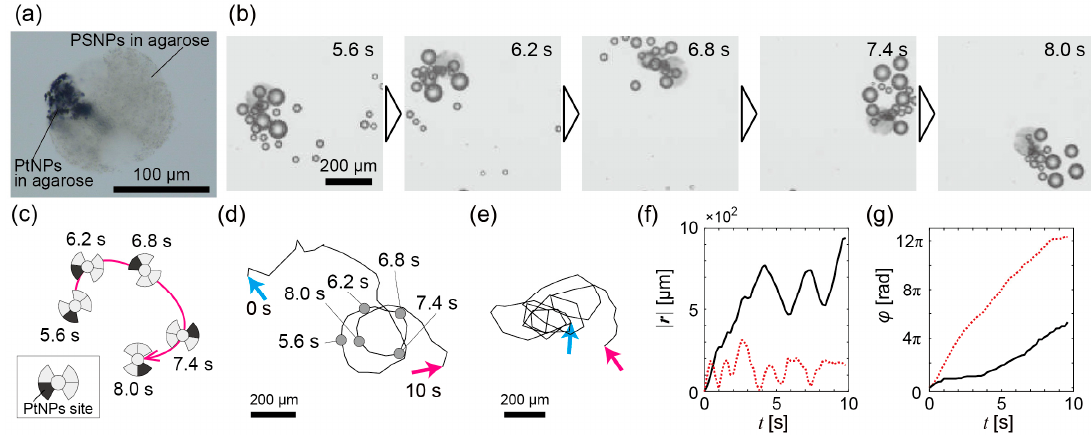
Figure 3. Experimental results of bubble propulsion of the propeller-shaped micromotors with double catalytic sites in the H 2 O 2 solution. ( a ) A microscope image of a propeller-shaped micromotor with double catalytic sites; ( b ) Time series from t = 7.8 s to t = 9.4 s of a propeller-shaped micromotor with double catalytic sites propelled by bubbles; ( c ) Schematic illustration of the trajectory of ( b ); ( d ) The whole trajectory of the micromotor in ( b ); Cyan arrow: t = 0 s; magenta arrow: t = 10 s; ( e ) Trajectory of another micromotor. The notation of arrows is the same as in ( d ); ( f ) The time variation of | r ( t )|. Black solid line: For trajectory of ( d ); red dashed line: For trajectory of ( e ); ( g ) The time variation of ϕ ( t ) . The notation of each line is the same as in ( f ).